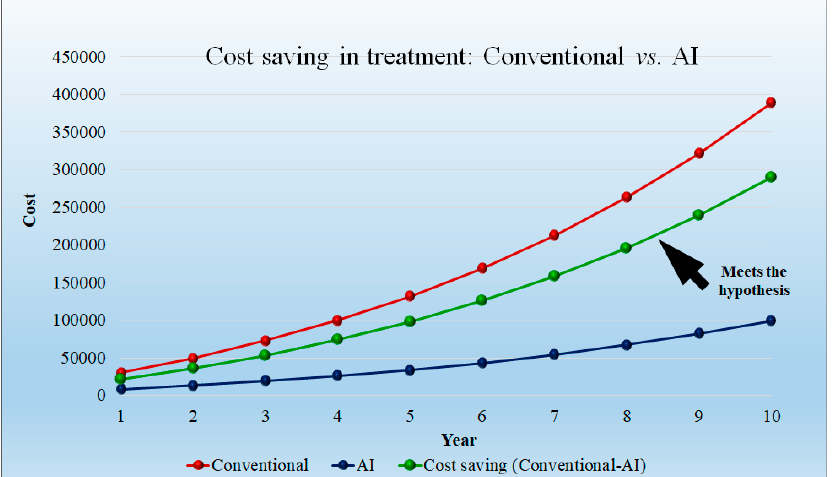
Figure 15. Cost saving in treatment (green) shows a non-linear curve. Conventional treatment cost (red) vs. AI treatment cost (blue).